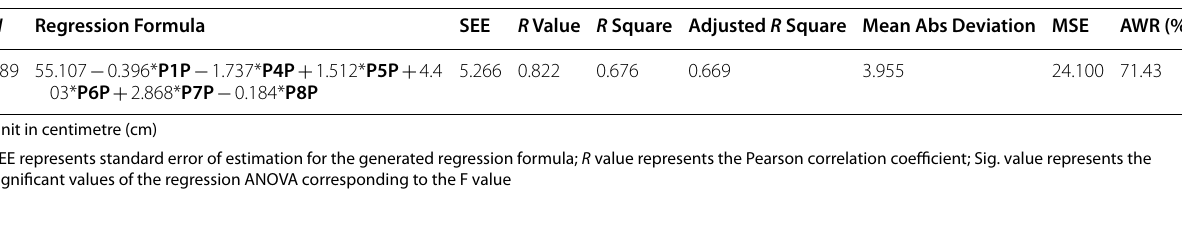
Table 12 Comparison of estimated stature by using formulae from different studies in validation analysis Transverse diameter S1 body